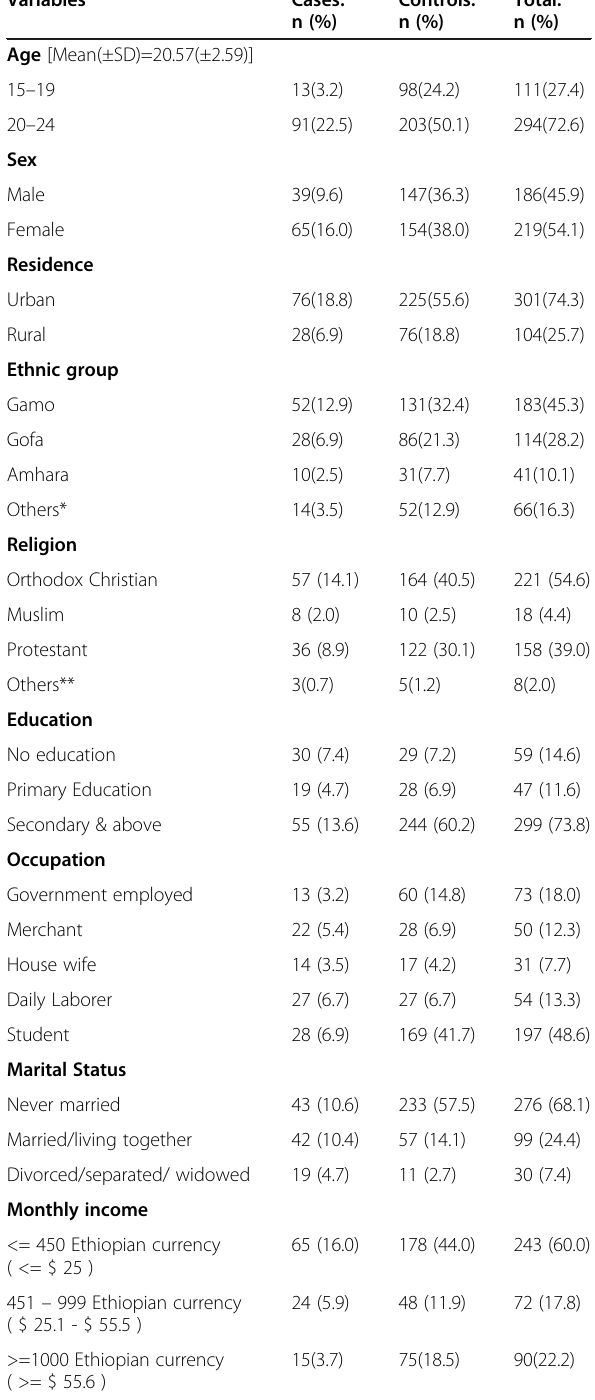
Table 1 Socio-demographic characteristics of youths visiting HIV testing and counseling centers in